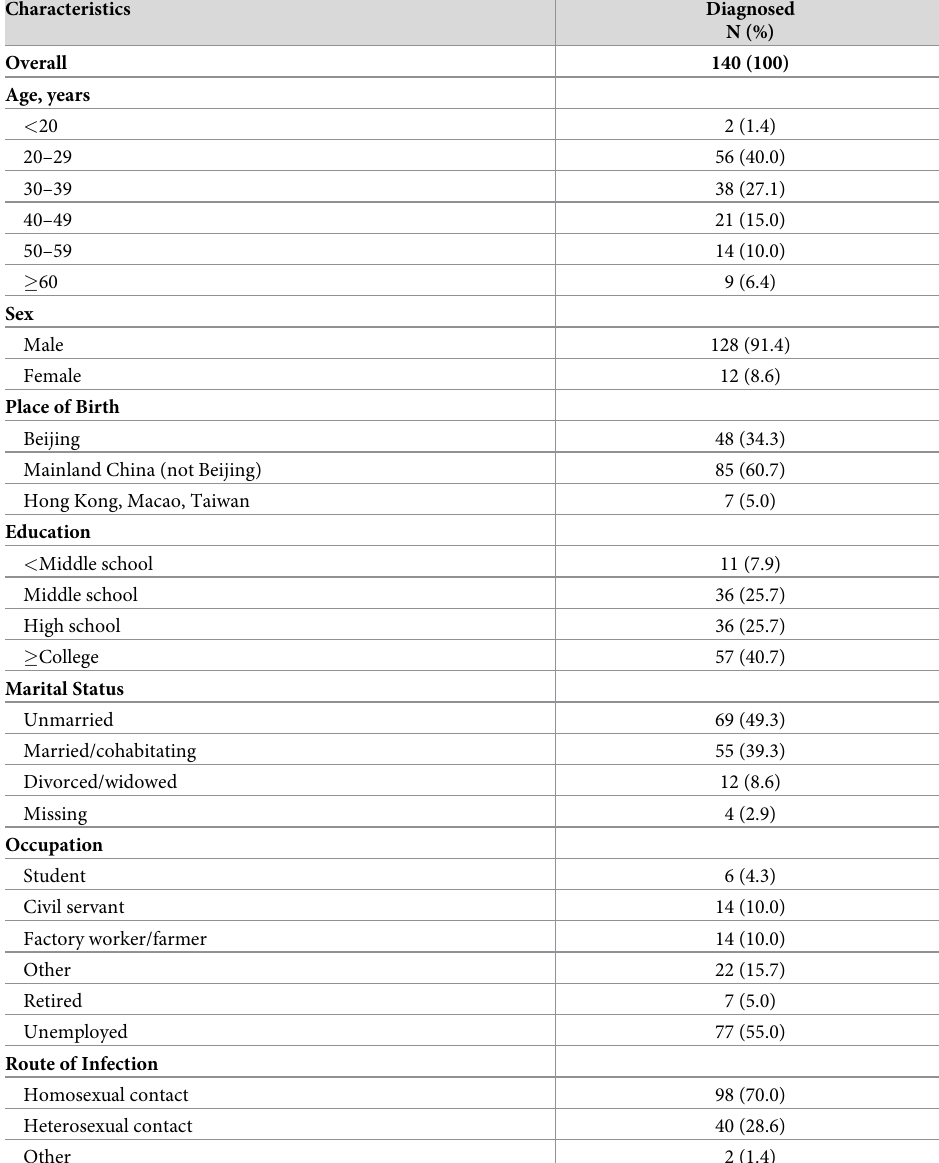
Table 4. Characteristics of patients diagnosed with HIV infection, at Xuanwu Hospital, Beijing, China, 2011– 2016.